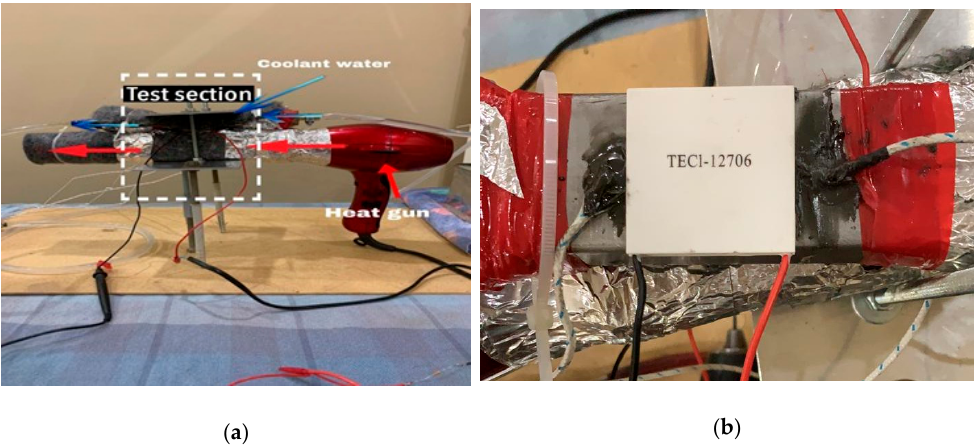
Figure 5. Experimental setup: ( a ) overview; ( b ) top view of the test section. Energies 2021 , 14 , 204